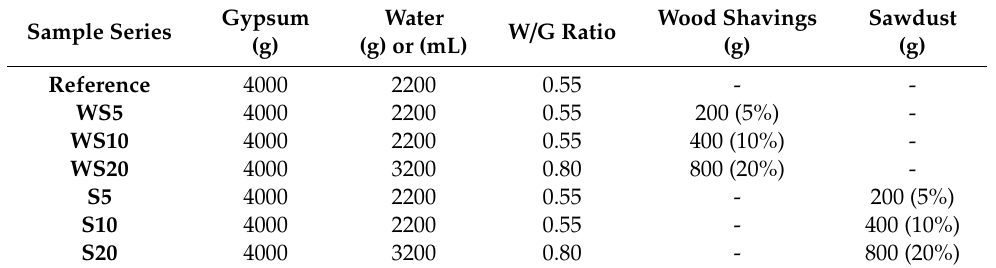
Table 2. Composition of the gypsum mixes for the 12 specimens of 40 × 40 × 160 mm 3 .